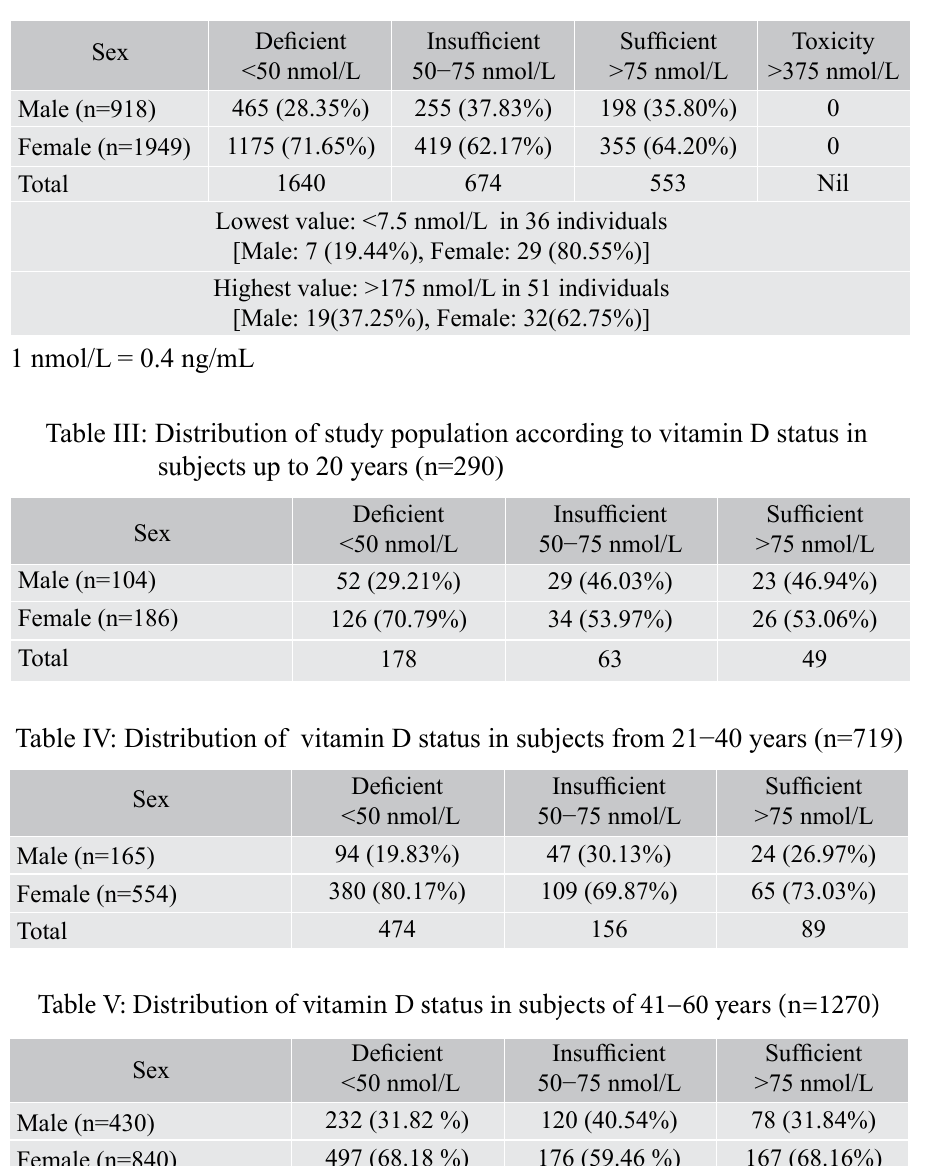
Table II: Distribution of subjects according to vitamin D concentration (N=2876)